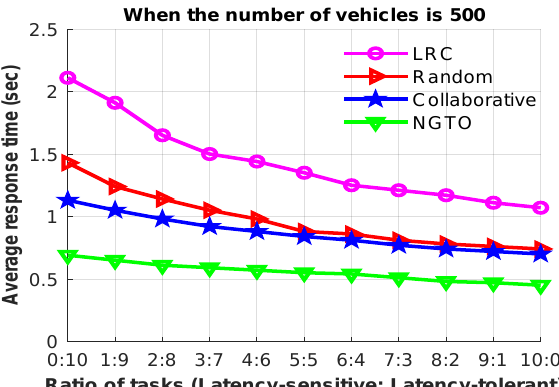
Figure 7. The average response time in terms of various ratios of latency-sensitive to latency- tolerant